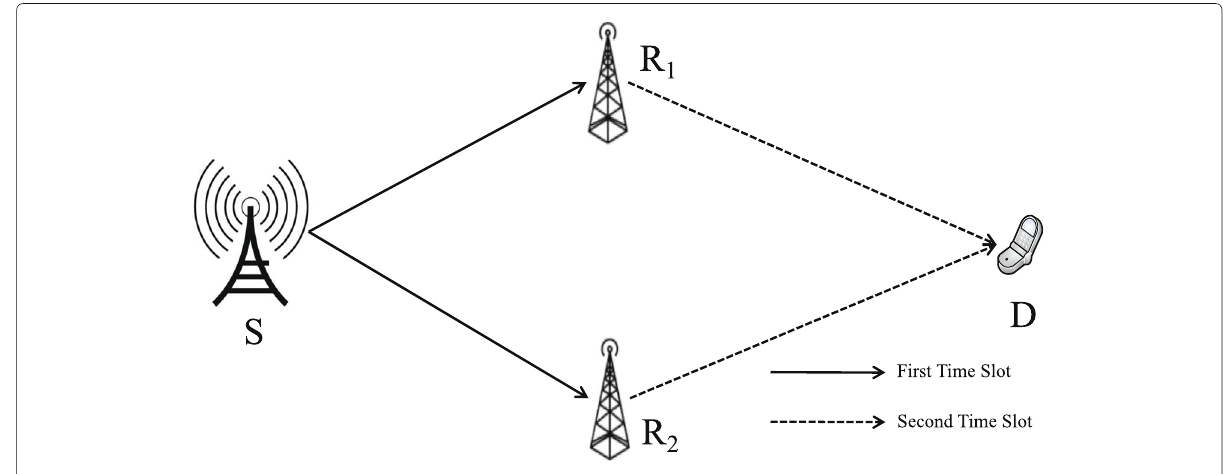
Fig. 1 The proposed cooperative two relaying system with